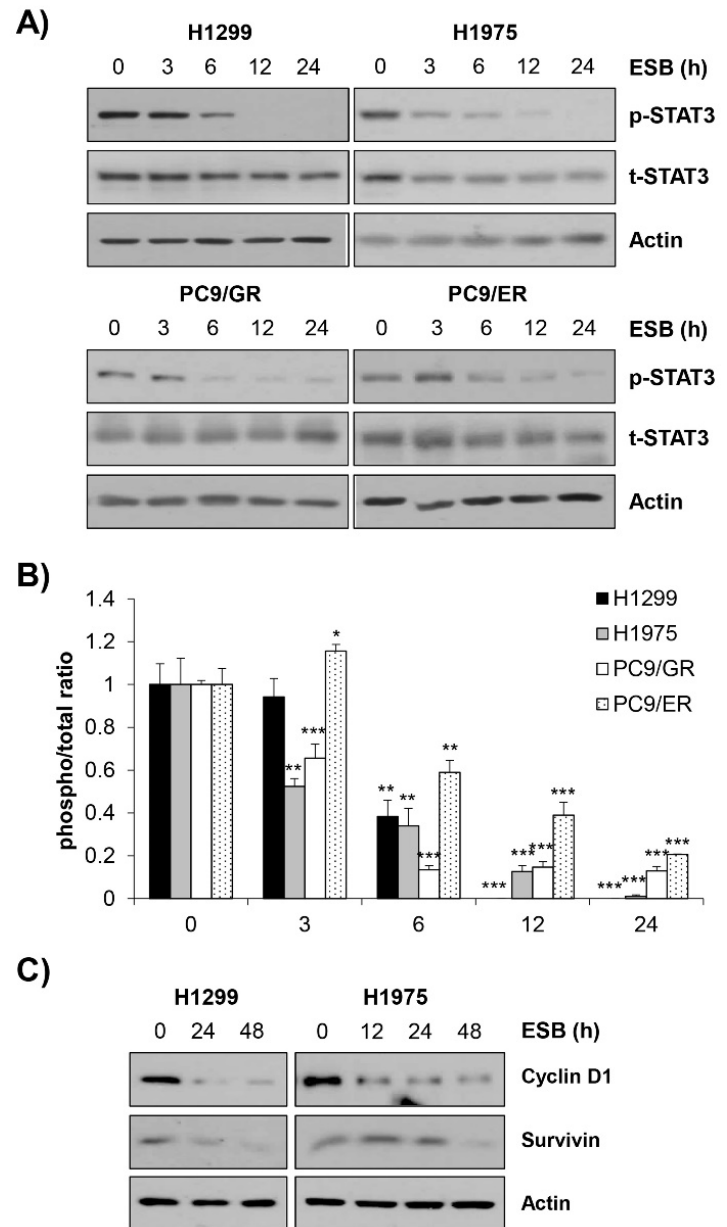
Figure 6. Suppression of STAT3 activity by ESB in EGFR TKI-resistant human NSCLC cell lines. H1299 ( EGFR wildtype; EGFR TKI-resistant), H1975 (acquired TKI-resistant), PC9/ER (acquired erlotinib-resistant), and PC9/GR (acquired ge- fitinib-resistant) human NSCLC cell lines were treated with 100 μ g/mL ESB for the indicated periods. ( A ) The levels of phosphorylated and total STAT3 were detected by Western blot analysis. Actin was used as a loading control. ( B ) The ratio of phosphorylated/total protein was calculated using ImageJ software after normalization to actin. The data are ex- pressed as the mean ± SD of duplicate experiments. Significance was determined by the Student’s t -test (* p < 0.05, ** p < 0.01, *** p < 0.001 vs. untreated controls). ( C ) The protein expression of STAT3 target genes was detected by Western blot analysis. Actin was used as a loading control. ESB, ethanol extract of the root of Scutellaria baicalensis; NSCLC, non-small- cell lung cancer; EGFR TKI, Epidermal growth factor receptor tyrosine kinase inhibitor; STAT3, signal transducer and activator of transcription 3; SD, standard deviation.